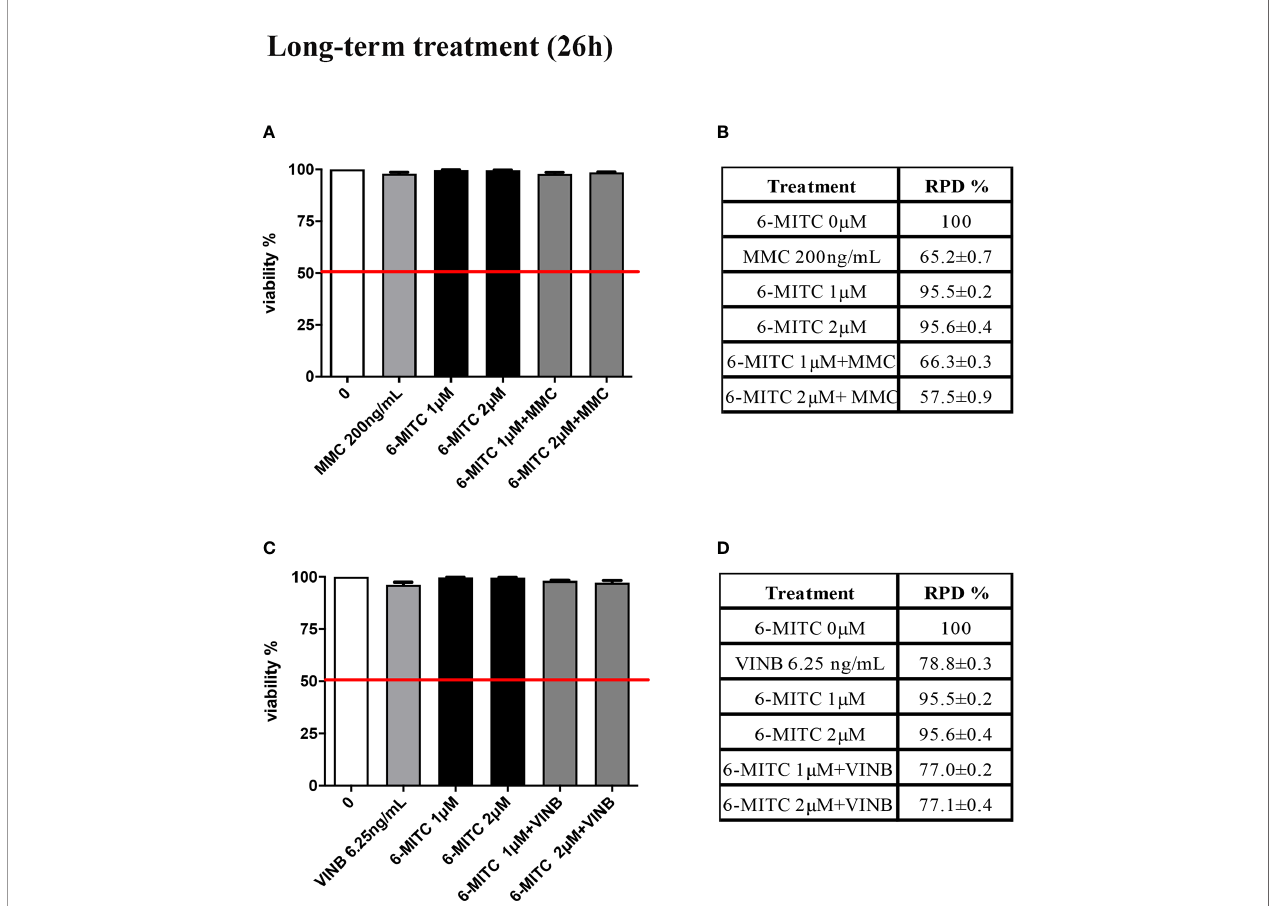
FIGURE 11 | Effect of 6-MITC on cytotocicity and cytostasis after long term treatment. Percentage of viable in TK6 cells treated with 6-MITC for 26h in presence or absence of MMC 200ng/mL (A) or VINB 6.25ng/mL (C) and relative RPD values for MMC 200ng/mL (B) or VINB 6.25ng/mL (D) . Each bar represents the mean ± SEM of fi ve independent experiments. Data represents the mean ± SEM of fi ve independent experiments Data were analysed using repeated ANOVA followed by Dunnet post-test.